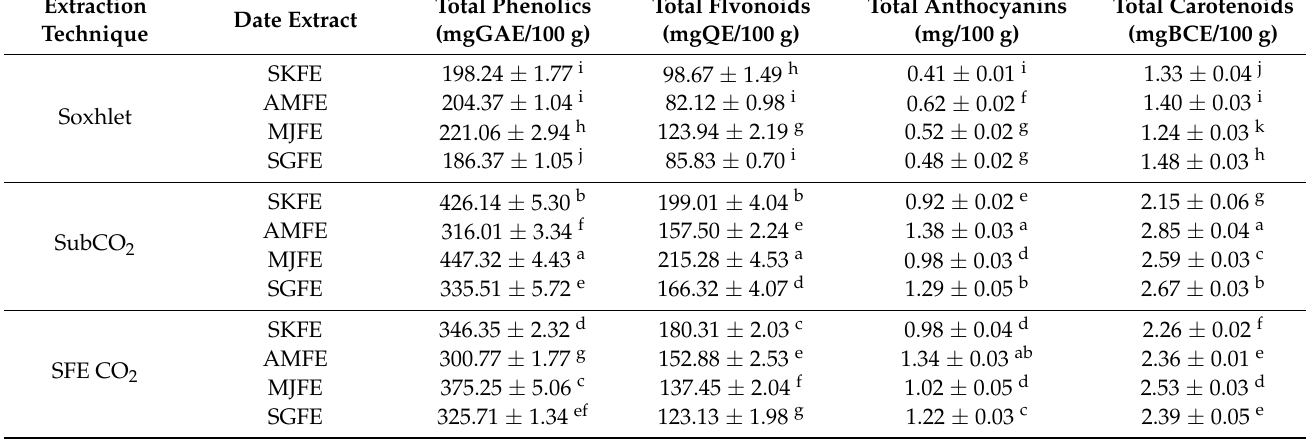
Table 3. Antioxidants and bioactive compounds of date fruit flesh extracts from four date varieties subjected to different extraction